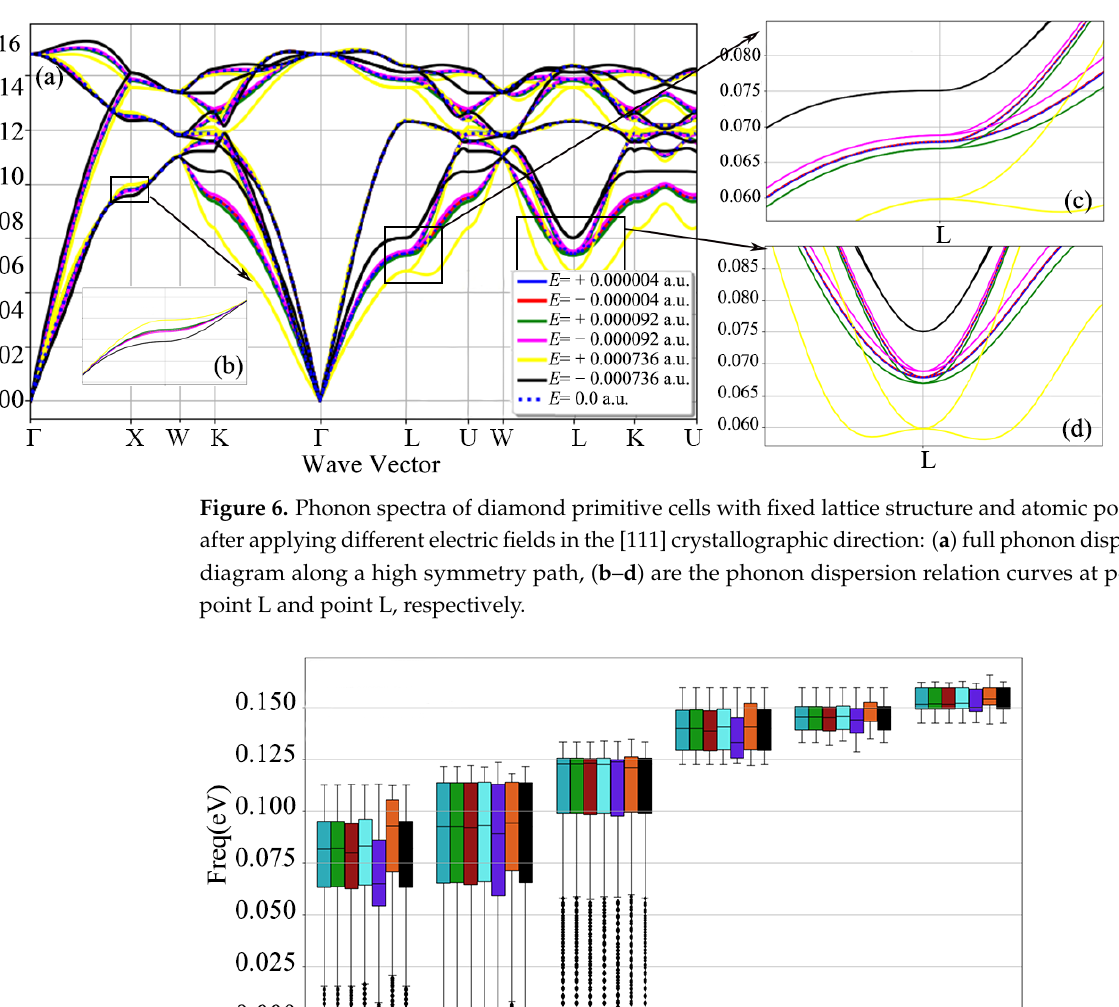
Figure 5. Frequency box plots of three acoustic branches and three optical branches of diamond after applying different electric field intensities along the [110] crystallographic direction.